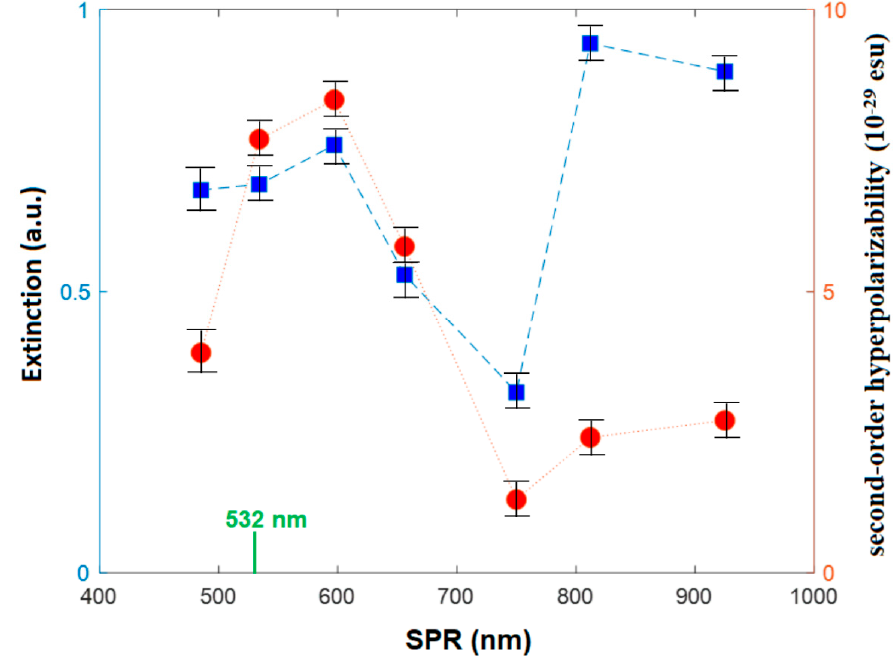
Figure 7. Trends of the SPR extinction (blue symbols) and the molecular second-order hyperpolarizability Γ (red symbols) values as a function of SPR position.